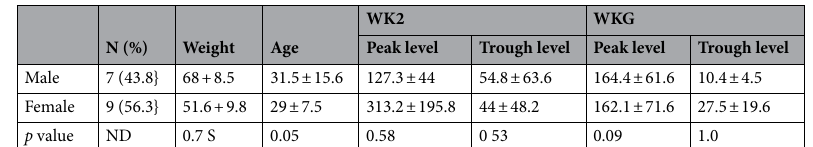
Table 2. Comparison of mean values between enrolled male and female patients.